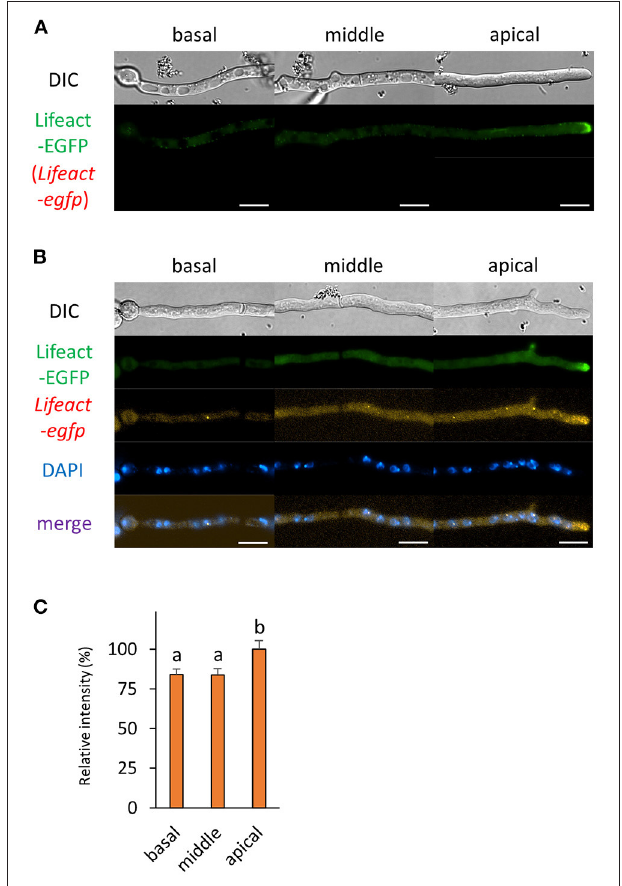
FIGURE 4 | The fluorescence derived from Lifeact-EGFP protein and Lifeact-egfp mRNA was observed in hyphal cells of the Lifeact-EGFP-expressing strain. (A) Lifeact-EGFP was observed in live cells. (B) smFISH with egfp probe resulted in the observation of the fluorescence of Lifeact-EGFP and Lifeact-egfp mRNAs. Nuclei were stained with DAPI. Bars, 10 µ m. (C) Relative fluorescence intensity of Lifeact-egfp mRNA was determined at apical, middle, and basal cells. Bars show mean with standard error. Significant difference at P < 0.05 between a and b (Tukey–Kramer test, n = 10